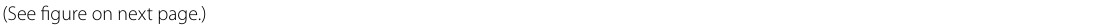
figure on next Fig. 1 a Phylogenetic tree constructed by the whole genome sequence together with DENV1-4 standard strains and genotype I, II, IV and V sequences. The sample lists are attached to the supplementary material. The accession numbers of newly defined samples are also described in supplementary materials. b Expanded phylogenetic tree constructed by the complete E gene sequence together with genotype I isolates recorded in the ViPR database from 6 southeast or East Asian countries. Open circle: the Vietnames isolates between 2006 and 2008; Open triangle: between 2009 and 2011; Open square: between 2012 and 2014: black triangle: between 2015 and 2016: black circle: 2017, analyzed in this